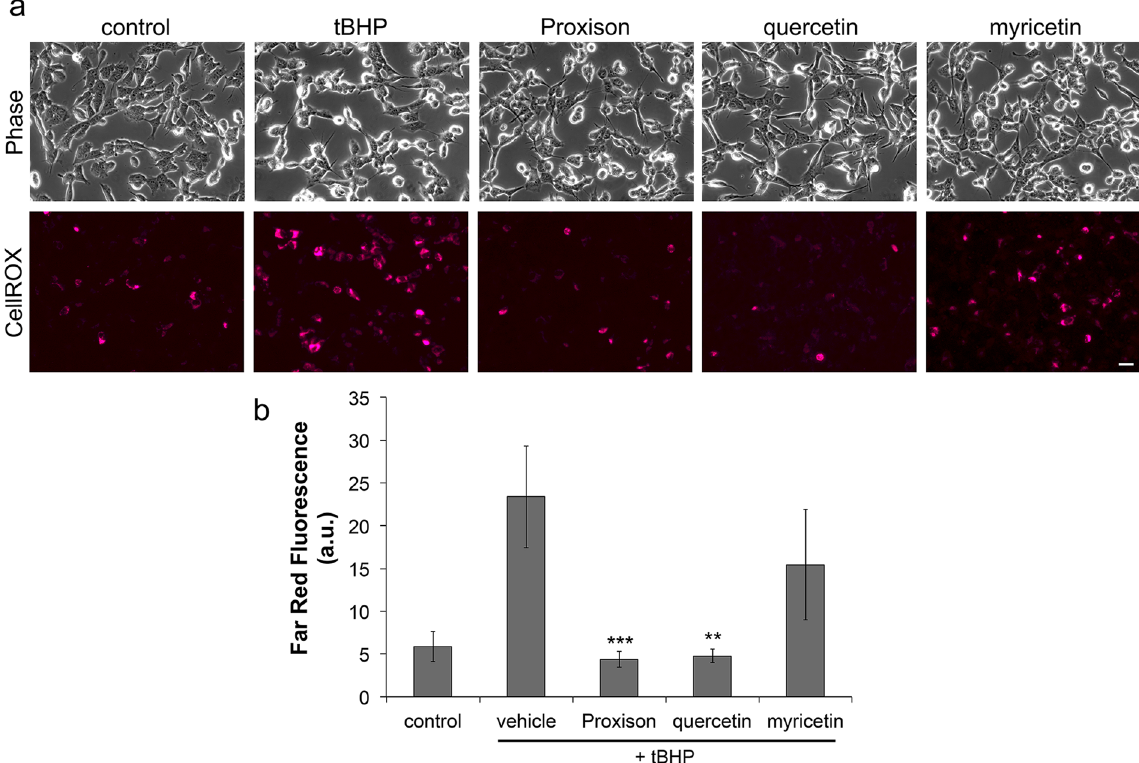
Figure 4. Intracellular scavenging of t BHP-induced radicals by antioxidants. ( a ) Intracellular ROS production in SH-SY5Y cells treated with t BHP in the absence or presence of Proxison (10 μ M), quercetin (100 μ M), or myricetin (100 μ M) was observed with CellROX ® Deep Red. Scale bar: 40 μ m. ( b ) The average intensity of CellROX ® Deep Red (far red) fluorescence of cells in the five conditions were quantified with Volocity software. Bars represent the mean from four independent experiments with duplicate cover slips for Proxison, and two independent experiments for quercetin and myricetin. Error bars represent the SEM. ANOVA with the post- hoc Tukey test was performed to assess significant difference to vehicle-treated cells; ** p < 0.01, *** p <